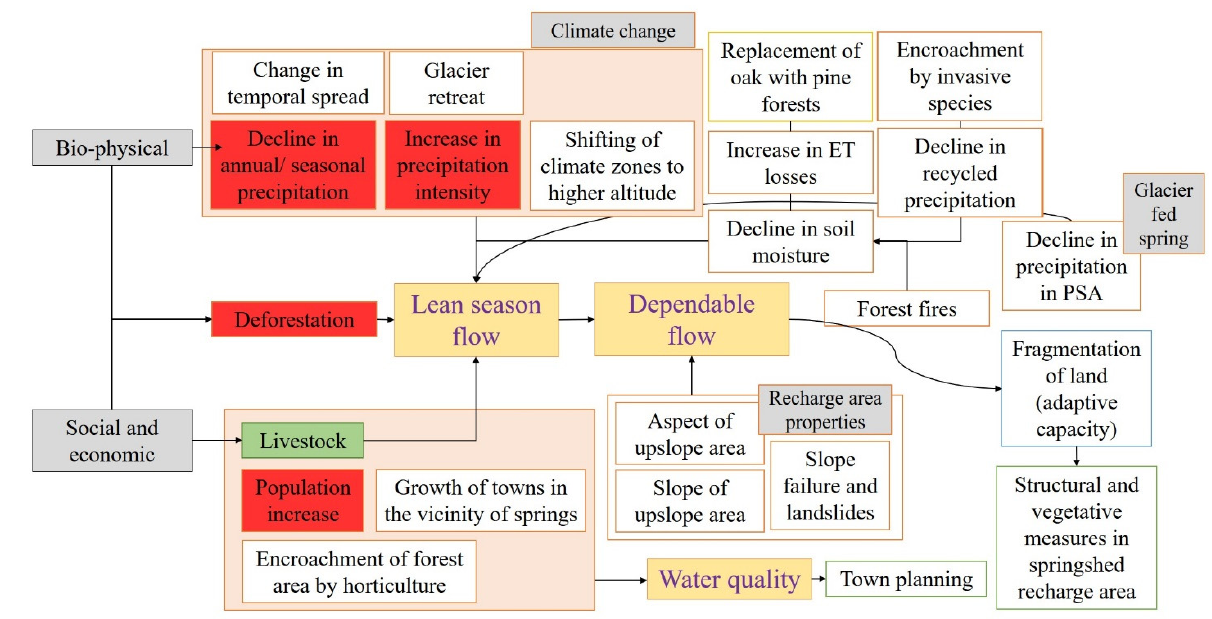
Figure 5. Vulnerability analysis of Mathamali spring, India.